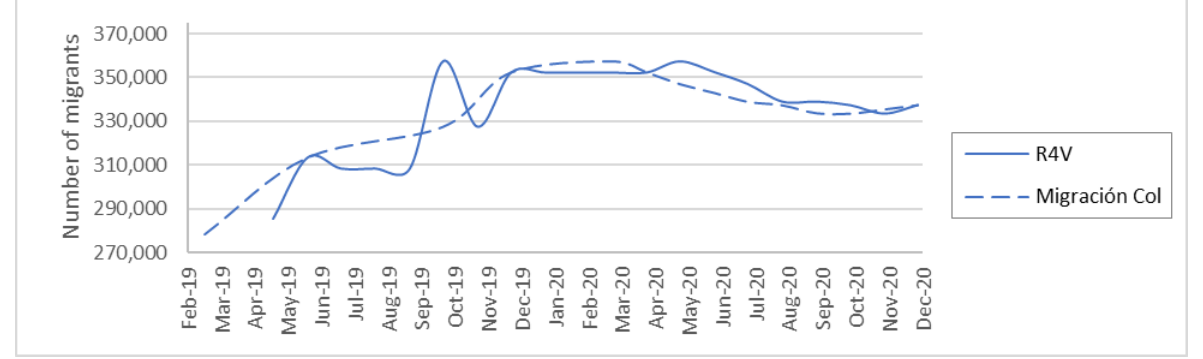
Figure 2. Comparison of Venezuelan migrants to Bogotá as reported by R4V vs. Migración Colombia.